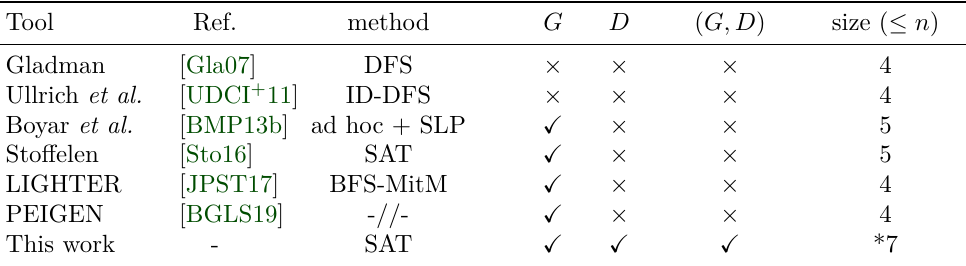
Table 1: Capabilities of several state-of-the-art tools regarding G and D . Tool